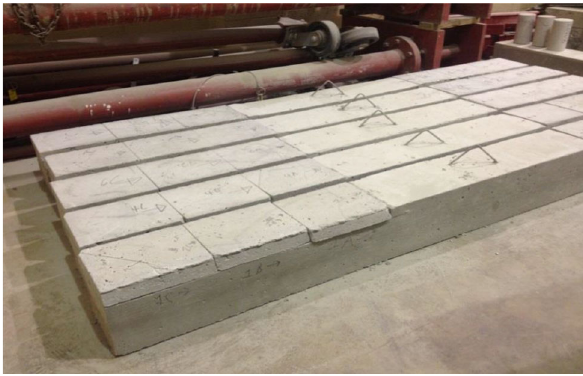
Fig. 9 Notched full-scale